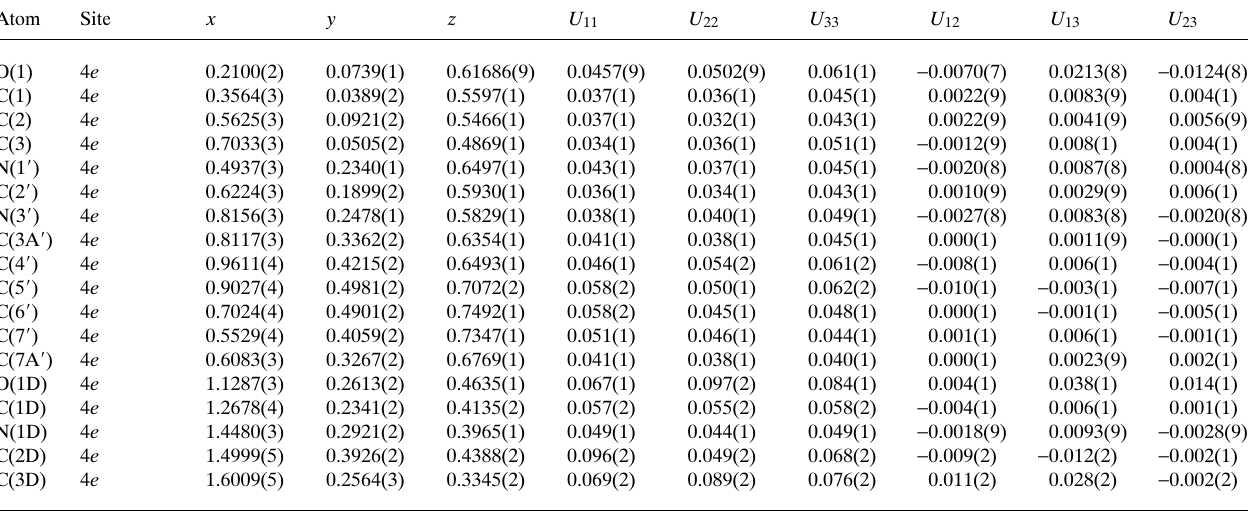
Table 3. Atomic coordinates and displacement parameters (in Å 2 )